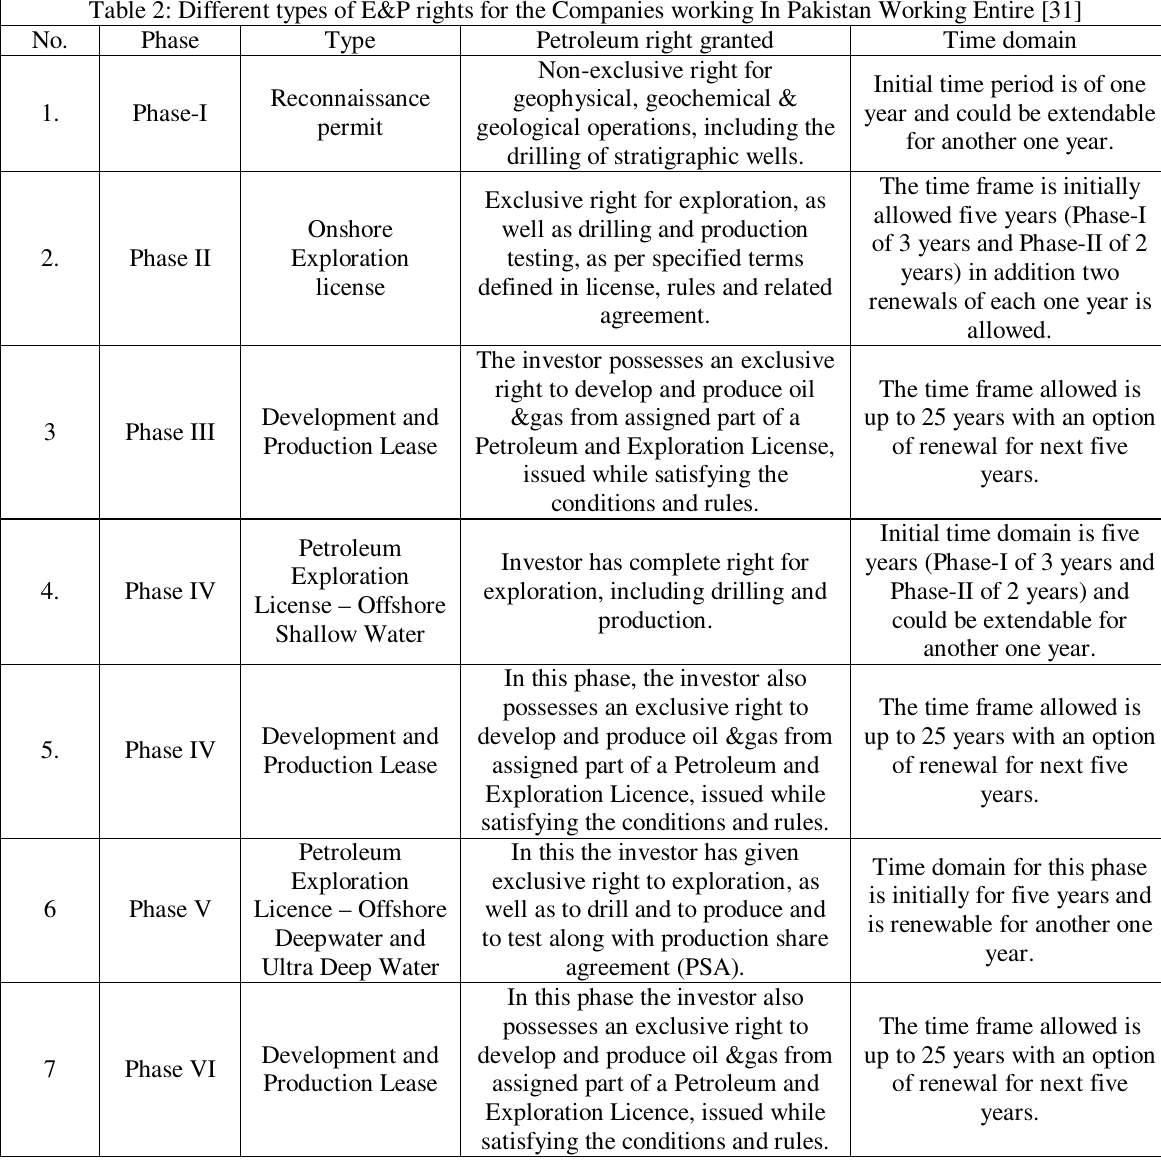
Table 2: Different types of E&P rights for the Companies working In Pakistan Working Entire [31] No. Phase Type Petroleum right